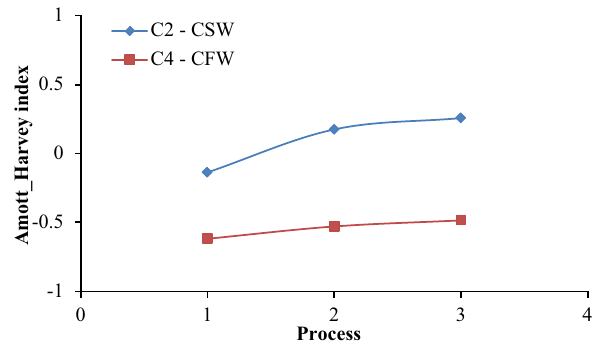
Fig. 13 Effect on the Amott–Harvey wettability index for limestones started with CSW and